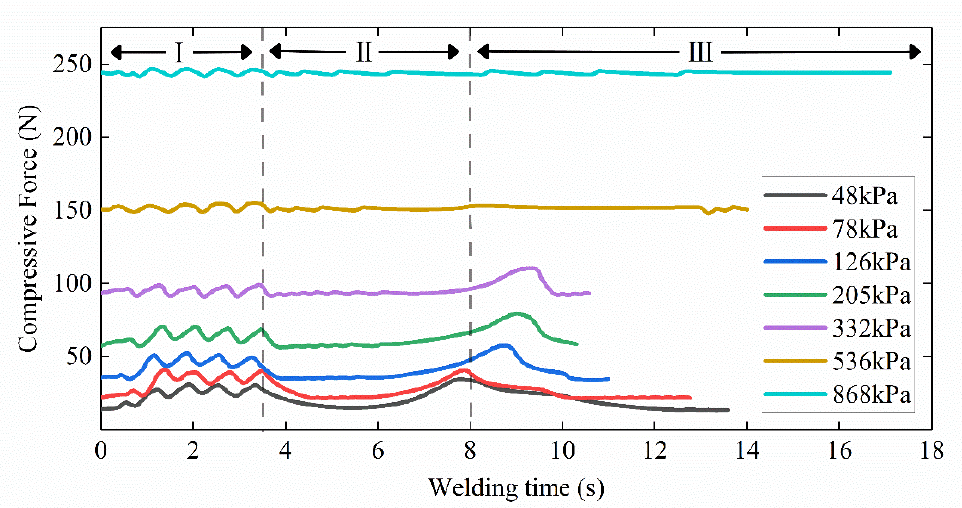
Figure 7. Compressive force between the electrodes during welding under seven levels of initial compression pressure. Pressure changes over time correspond to three stages of impedance change over time. Period I is erratic, Period II is steady, and Period III is distinct due to differences in initial compression pressure. Compression force above the initial setting would cause the contact impedance between the electrode and the tissue to decrease.